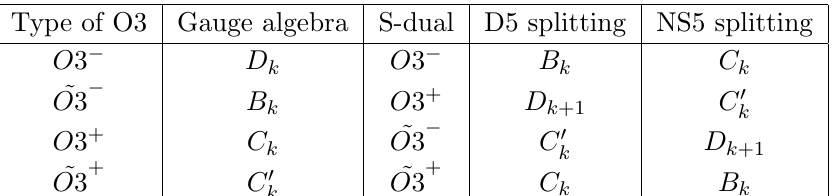
Table 2 . The (cid:12)rst column enumerates all possible orientifold O3 planes. The second column then gives the gauge algebra of the theory with k coinciding branes on the orientifold. The third column indicates how the orientifold planes transform under S-duality of type IIB string theory. The fourth and (cid:12)fth columns give the gauge algebra of the world-volume theory between two half D5 or half NS5 branes after splitting on the corresponding orientifold. In particular, brane creations occur in some cases, as can be seen by the increase in rank of the gauge algebra.